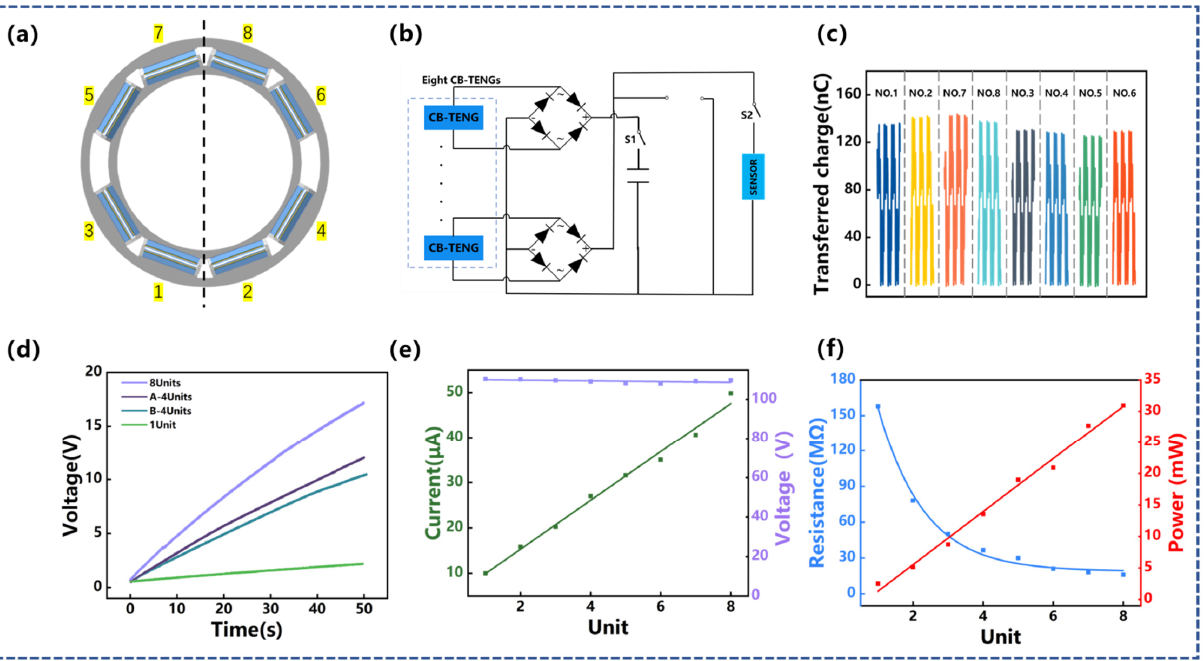
Figure 5. The output performance of the array-type CB-TENG for vibration energy harvesting: ( a ) Array-type CB-TENG layout diagram; ( b ) the working circuit of array-type CB-TENG for vibration energy harvesting to power sensor or testing; ( c ) transferred charge for each TENG unit in the CB- array-type TENG; ( d ) charging performances to a capacitor of 10 μ F for different CB-TENG arrays; ( e ) open-circuit voltage and short-circuit current with different amounts of integrated units; ( f ) the output power and the external load resistance with different amounts of integrated units working at f = 3 Hz, A = 50 mm.